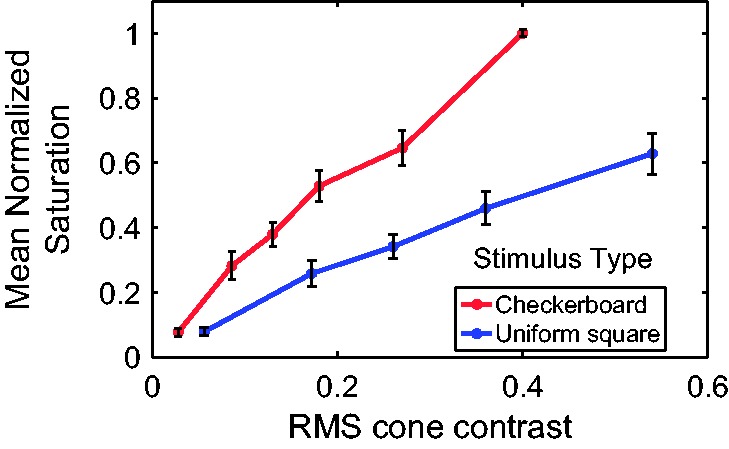
Normalized saturation scaling data averaged across all participants, presented as a
function of RMS cone contrast for the checkerboard (red) and uniform colored square
(blue) patterns. Error bars represent ±1 SEM. Note that the cone
contrast of the uniform square was scaled to take into account the fact that the
space-averaged cone contrast of the red–gray checkerboard was one-half that of a
uniform square of the same chroma or cone contrast (compared with the equiluminant
gray).